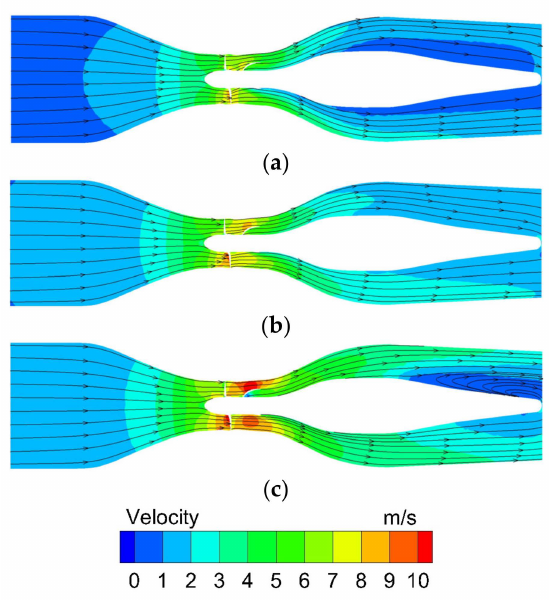
Figure 9. Streamlines and velocity contour on cross section in shaft rear-positioned tubular pump device: ( a ) Q/Q d = 0.8; ( b ) Q/Q d = 1.0; ( c ) Q/Q d =